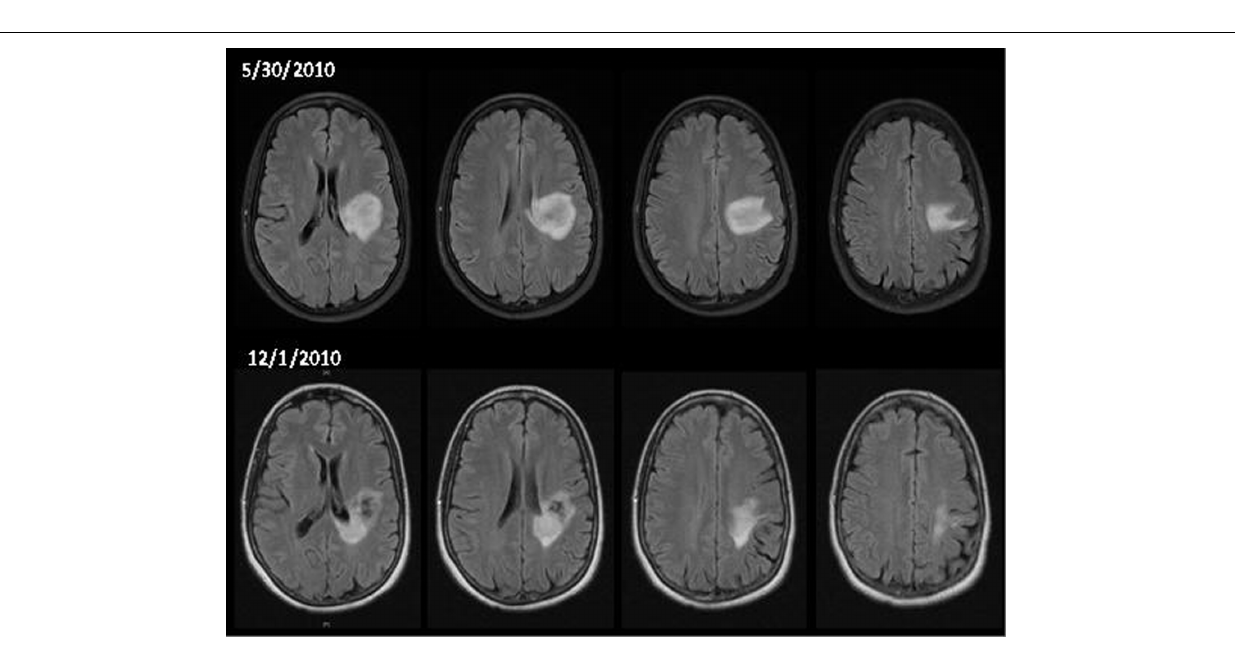
FIGURE 7 | Comparison of brain MRI at presentation (May 30, 2010) and follow-up (December 1, 2010) showing a discrete contiguous lesion just posterior to the previous